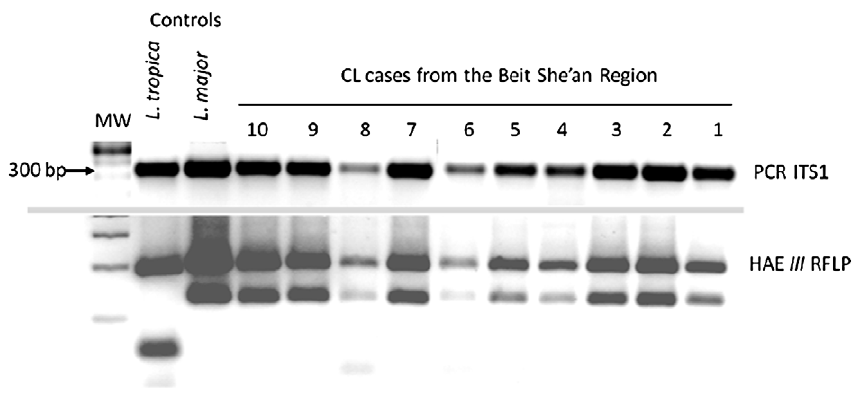
Figure 2. ITS1 PCR gel electrophoresis of DNA from lesion biopsies of ten cases of CL from Sde Eliyahu. Top panel 300 bp, Leishmania ITS1 PCR product. Bottom panel shows the HAE III restriction fragments of the ITS1 PCR product. Note the double-bands, identical to the pattern of L. major and very different from the L. tropica control.